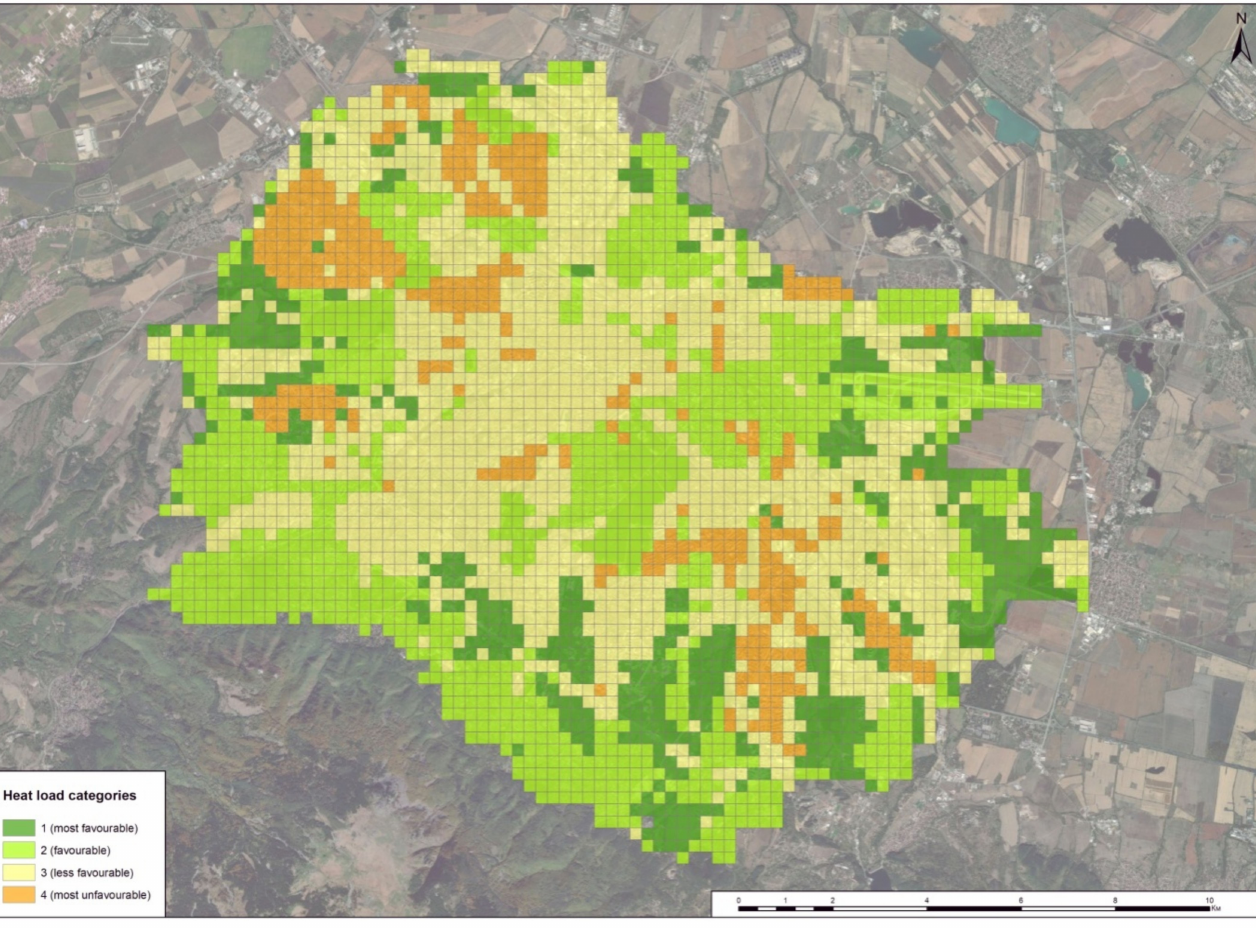
Figure 4. Map of heat load